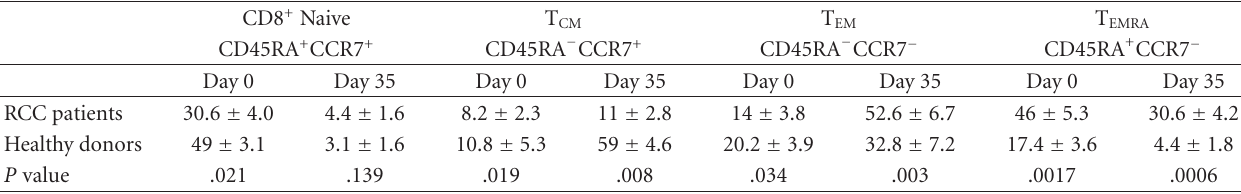
Table 2: Flow cytometry analysis of CD45RA/CCR7 expression on CD8 + T cells at day 0 and after 35 days of MLTC . Di ff erential expression of the CD45RA, CCR7 cell surface molecules was analyzed on CD8 + T cells at day 0 and after extended MLTC stimulation. CD8 + T cells were separated into four subsets ( T N , T CM , T EM , T EMRA ) based on di ff erential expression of the CD45RA and CCR7 markers. Results are the mean (+ / − SD) of values obtained from 5 RCC patients and their corresponding HLA-matched normal